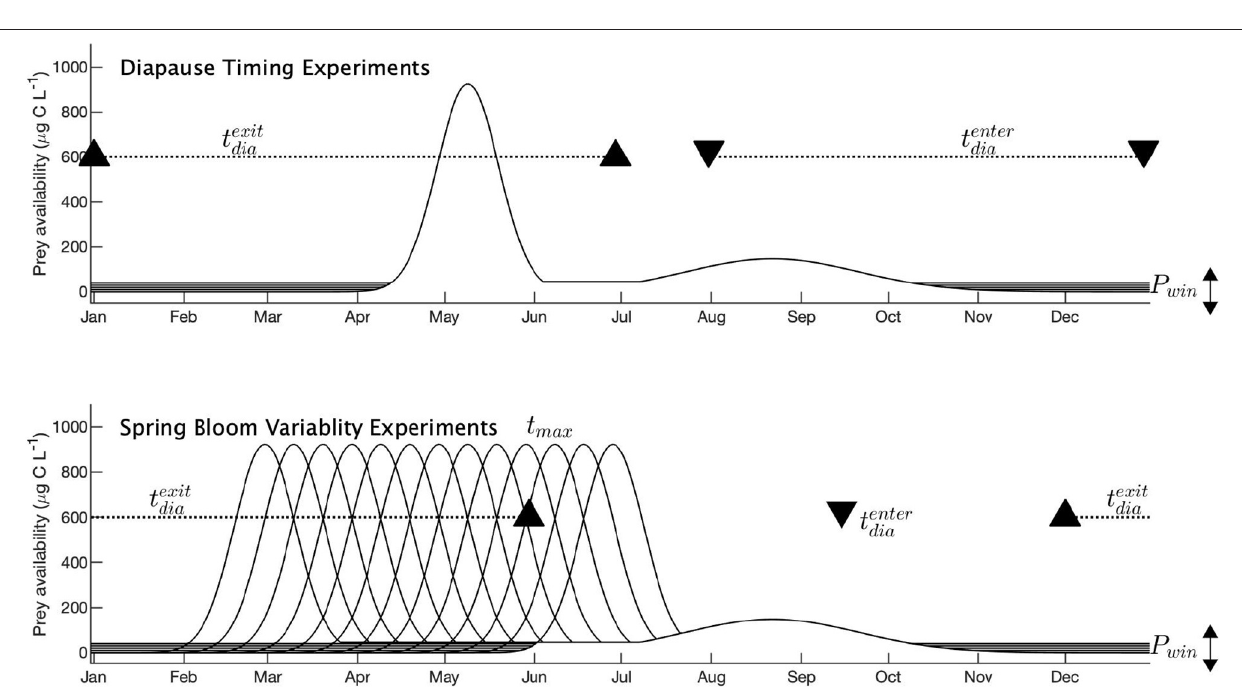
the spring bloom (April). As the value of P win increases, the range of viable strategies becomes broader. Entering